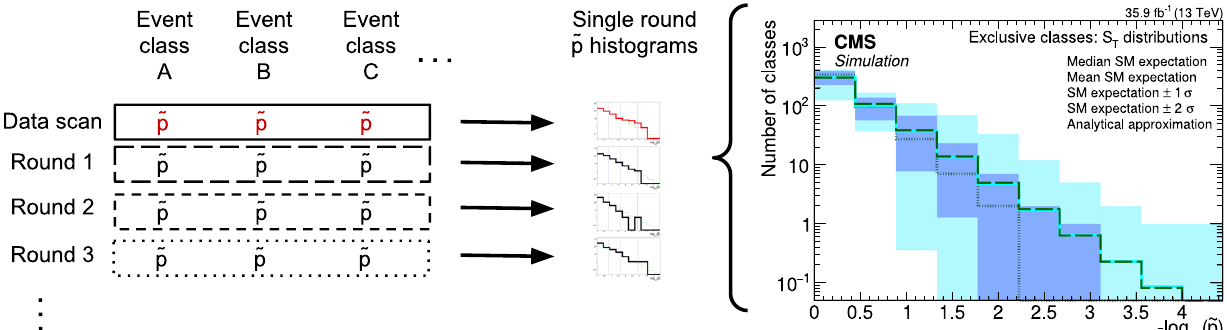
Fig. 3 Illustrative example of a ˜ p value distribution for different event classes (final states) based on a RoI scan of an S T distribution. His- tograms of the number of event classes corresponding to a bin in − log ( ˜ p ) forthedifferentpseudo-experimentiterations(shownonthe 10 left) are used to create the global overview plot for a scan of each partic- ular kinematic distribution for each event class type (shown on the right for an S T distribution scan in exclusive event classes, without showing